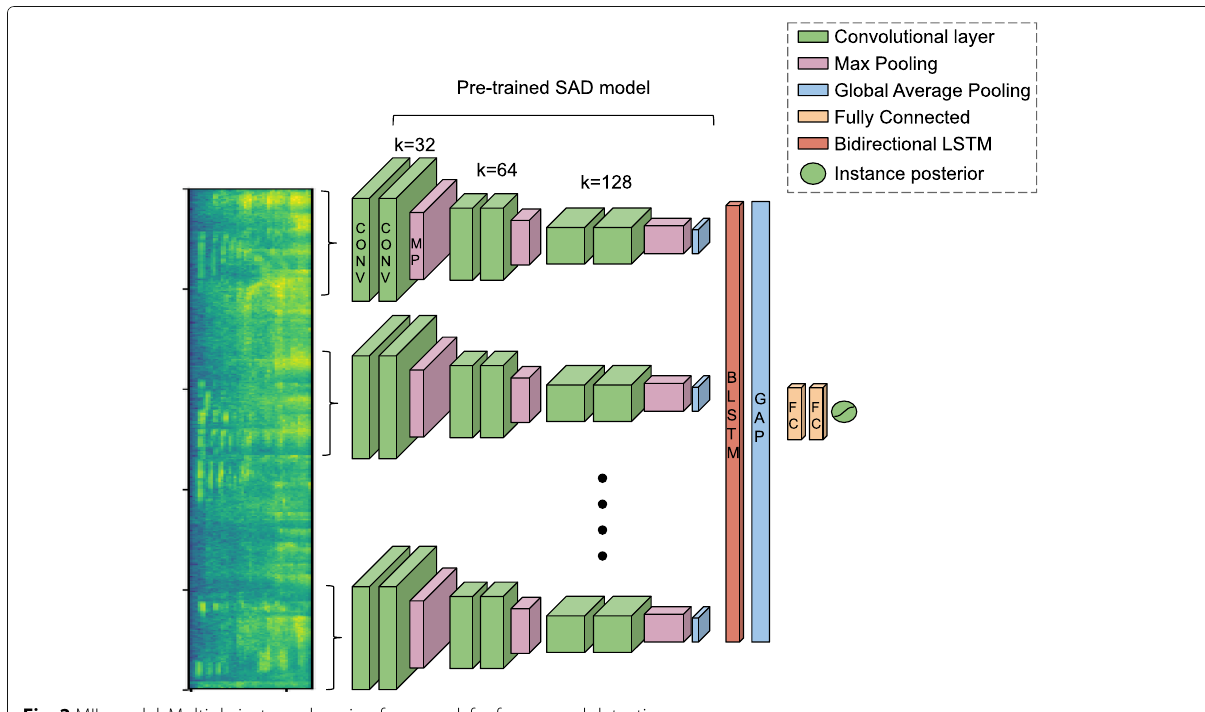
Fig. 2 MIL model. Multiple instance learning framework for foreground detection